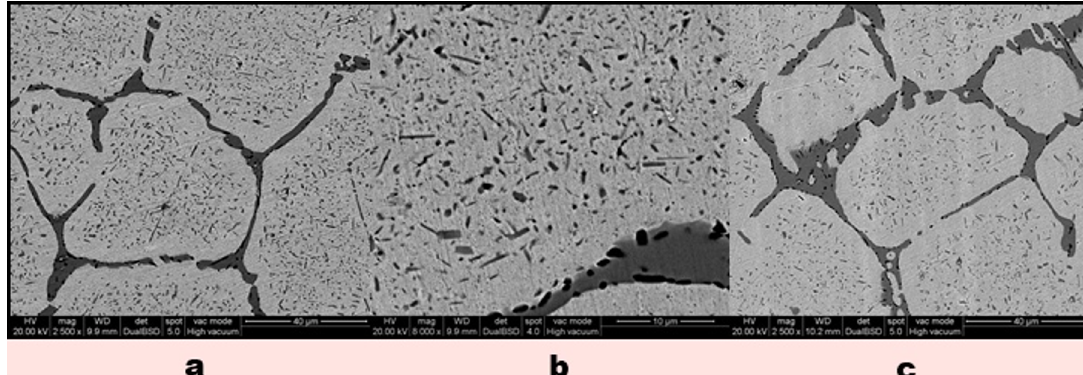
Figure 4. CuNiSiCr Alloy annealed at 950 °C for 7.5 hours (a) oven-cooled for 24 h, (b) zoom of the above micrograph and (c) quenched. to the silicides of nickel, similar to the events occurring at the grain boundaries are observed. The adjacencies of the grains are free from precipitation.